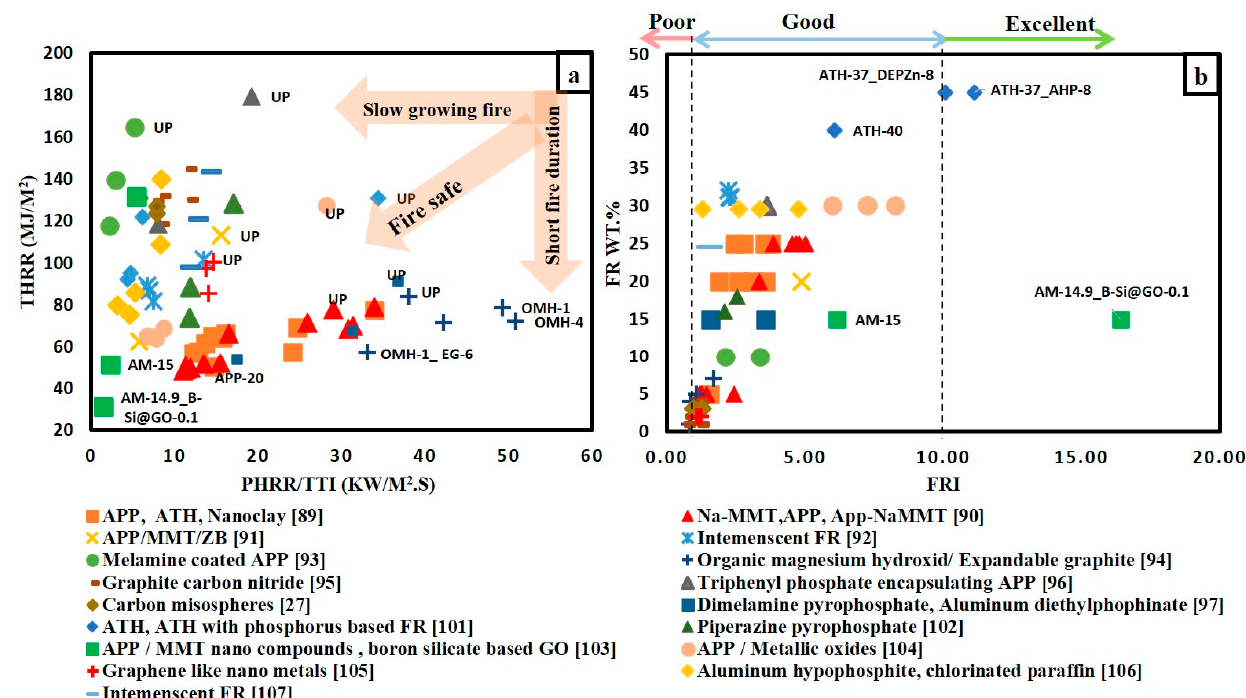
Figure 5. ( a ) THRR versus PHRR/TTI for various FR/Unsaturated polyester resin; ( b ) flame retardancy index (FRI) for different FR/unsaturated polyester system with respect to weight content of FRs.